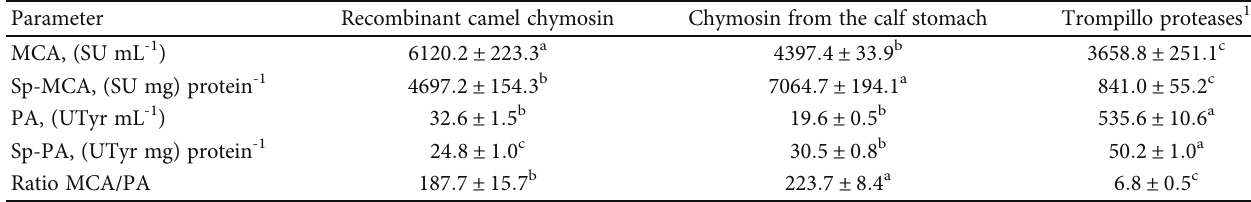
Table 2: Milk-clotting and proteolytic activities of proteases used in this study. Parameter Recombinant camel chymosin Chymosin from the calf